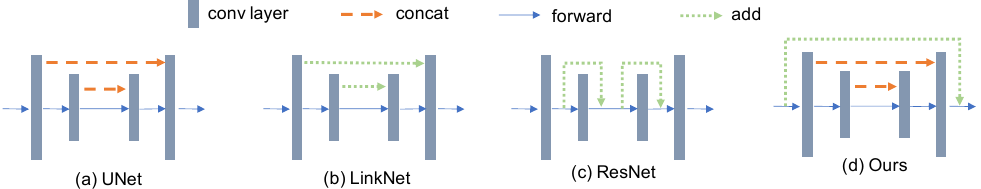
Figure 11. Diagram of the network structure of ( a ) UNet [4], ( b ) LinkNet [51], ( c ) ResNet [44], and ( d ) ResiDualGAN